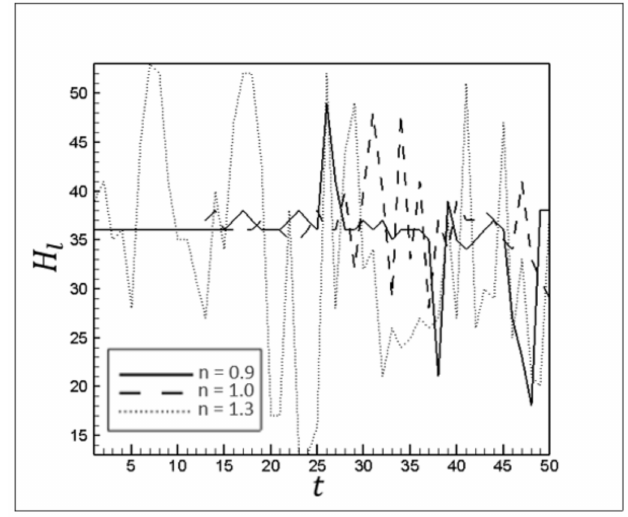
Figure 18. The attacking front height, H L , over time for different n.